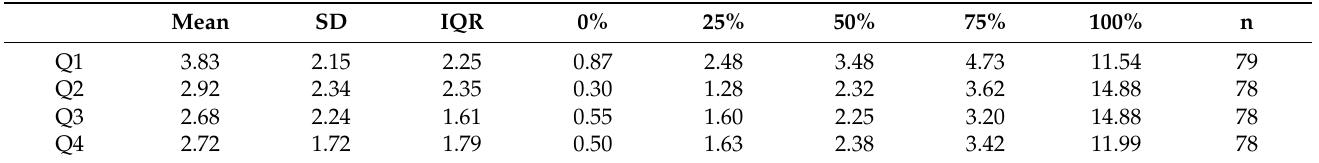
Table 9. Percentage of foreign people. Sources: own elaboration based on data from the Galician Institute of Statistics (IGE), Municipal Register of Inhabitants, the year